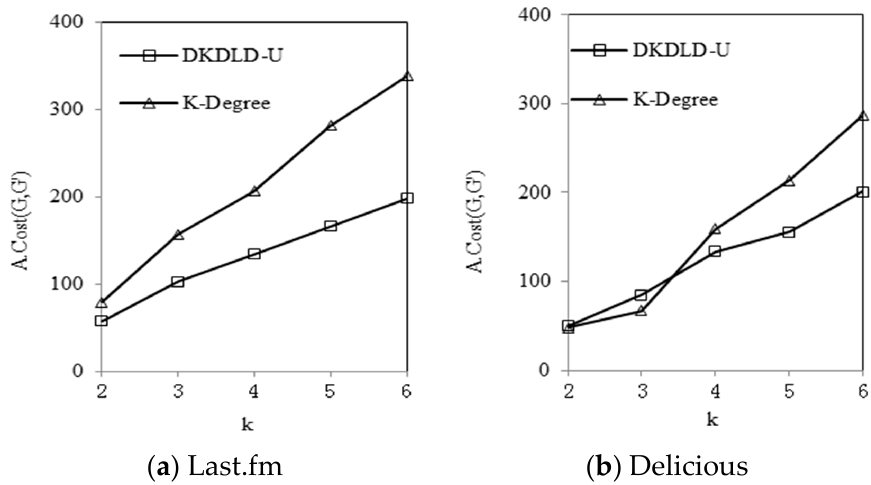
Figure 5. Last.fm dataset ( a ) and Delicious dataset ( b ): costs for different k values.